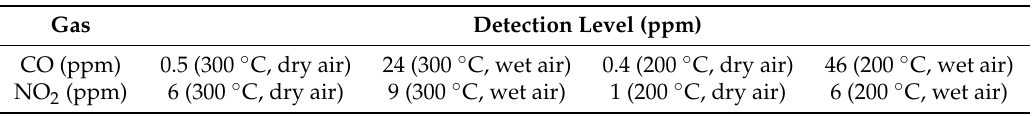
Table 7. Limits of detection of CO and NO 2 using the SnO 2 ink jet-printed